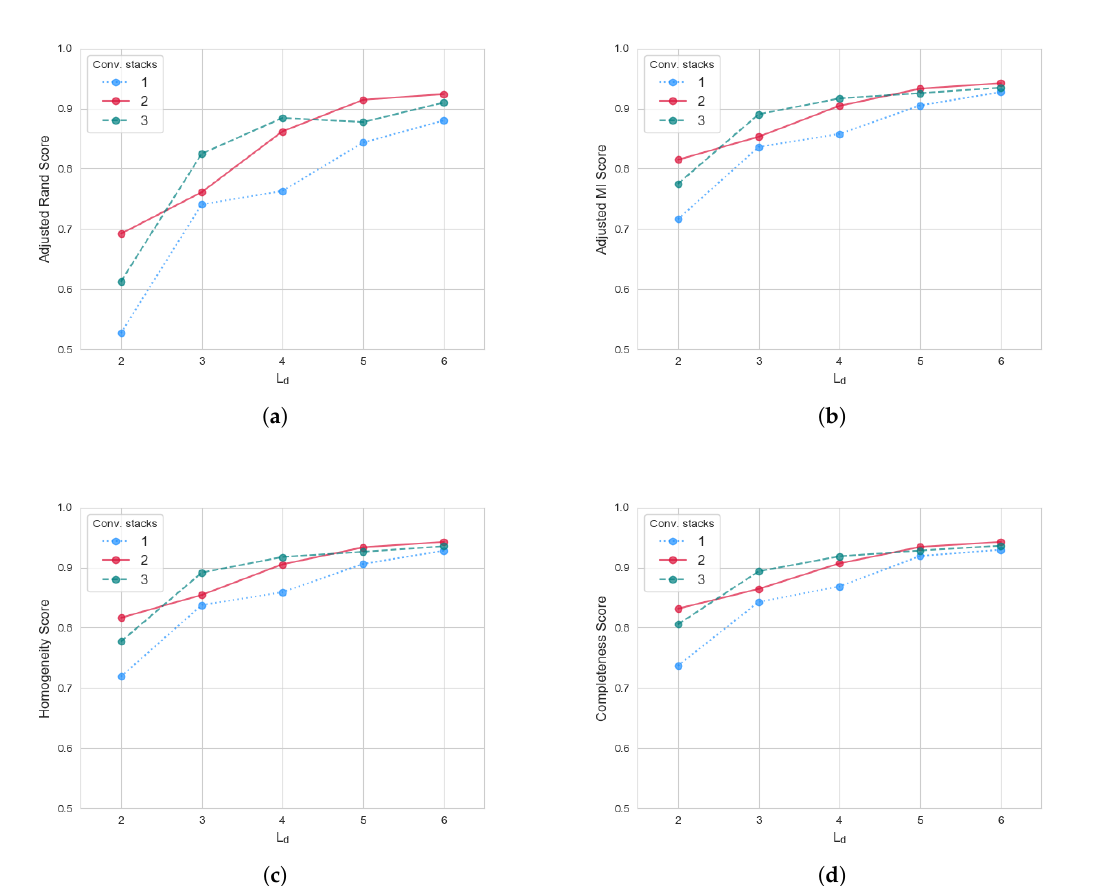
Figure 5. SCG deep clustering performance with respect to latent dimension L d : ( a ) Adjusted Rand Score, ( b ) Adjusted Mutual Information Score, ( c ) Homogeneity, and ( d ) Completeness. Performances for a different number of conv-stacks are superimposed, using different colors and line